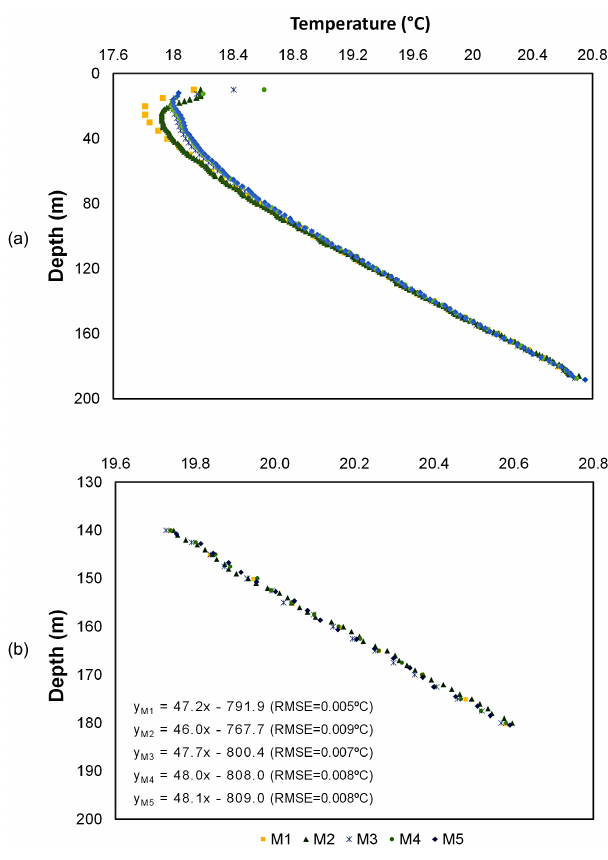
Figure 1. (a) Borehole temperature logs (temperature vs. depth) for M1, M2, M3, M4 and M5 from the Évora observatory (cf. legends). (b) The same as (a) , but only for the data from the bottom 140– 180m. The outlined equations of the respective regression lines (omitted) represent the corresponding estimated geothermal gradi- ents (slope of the linear regression